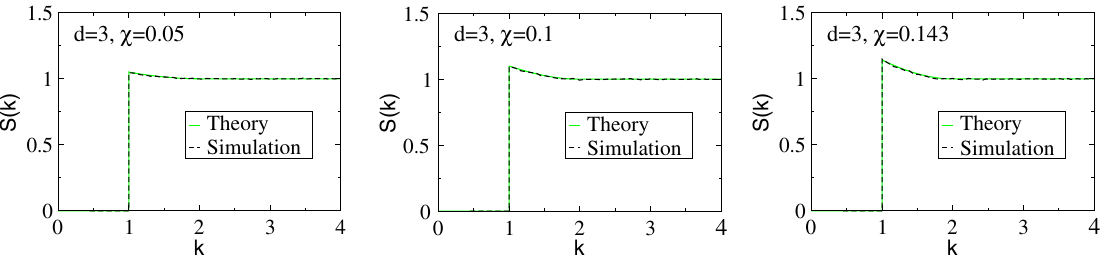
FIG. 6. Comparison of theoretical and simulation results for the structure factor S ð k Þ for χ ¼ 0 . 05 , 0.1, and 0.143 for d ¼ 3 . Here, K ¼ 1 .